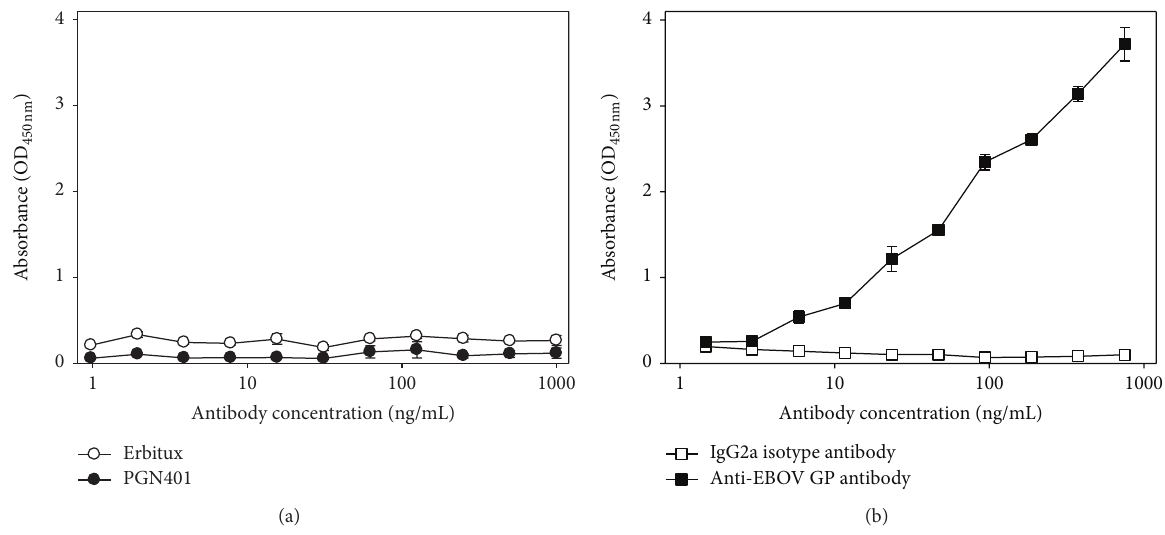
Figure 4: Binding of antibodies to recombinant EBOV glycoprotein. (a) Erbitux and PGN401 antibodies. (b) Polyclonal anti-EBOV glycoprotein antibody and IgG2a isotype control. Data points show mean values from three replicate wells with error bars denoting standard